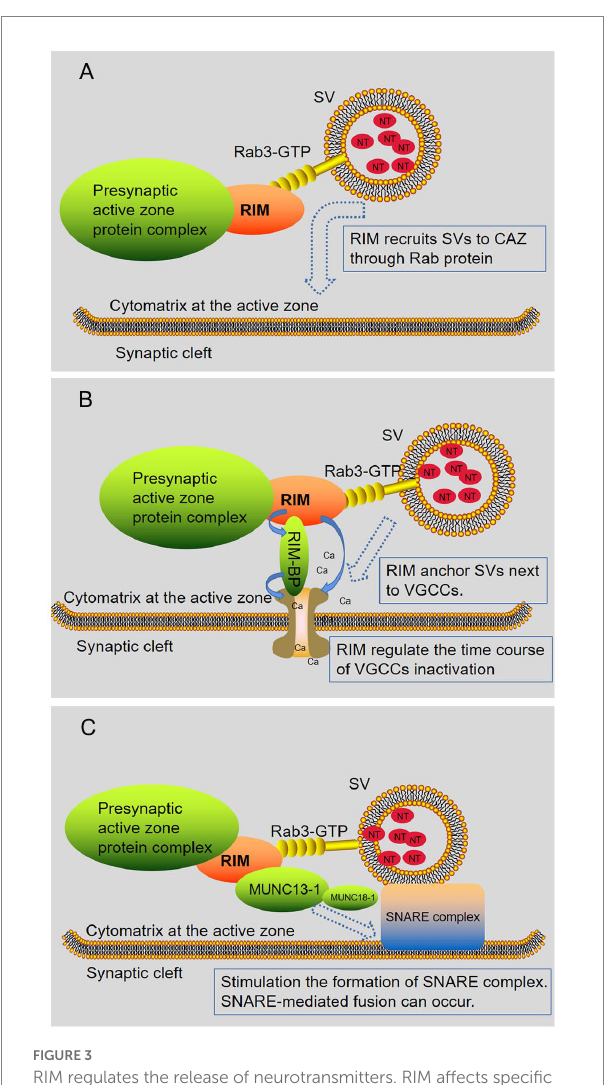
FIGURE 3 RIM regulates the release of neurotransmitters. RIM affects specific stages of the SV exocytotic cycle. (A) RIM recruits SV via Rab proteins (Rab3 and Rab27 subtypes). (B) RIM anchors SV next to VGCCs. RIM directly binds Ca2 + channels or indirectly binds them through RIM- BPs, recruiting Ca2 + channels for rapid excitation-secretion coupling. In addition, RIM regulates the time course of VGCC inactivation, resulting in a sustained Ca2+ influx. (C) RIM, Rab3, and Munc13-1 regulate the late steps in SV fusion. Subsequently, the Munc13-MUN domain activated the Munc18-1/Syx1 complex, thus promoting the formation of the SNARE complex. After this step, an action potential is triggered, and SNARE-mediated fusion can occur. In short, RIM affects the docking of SV with fusion mechanism proteins (SNARE) and Ca2+